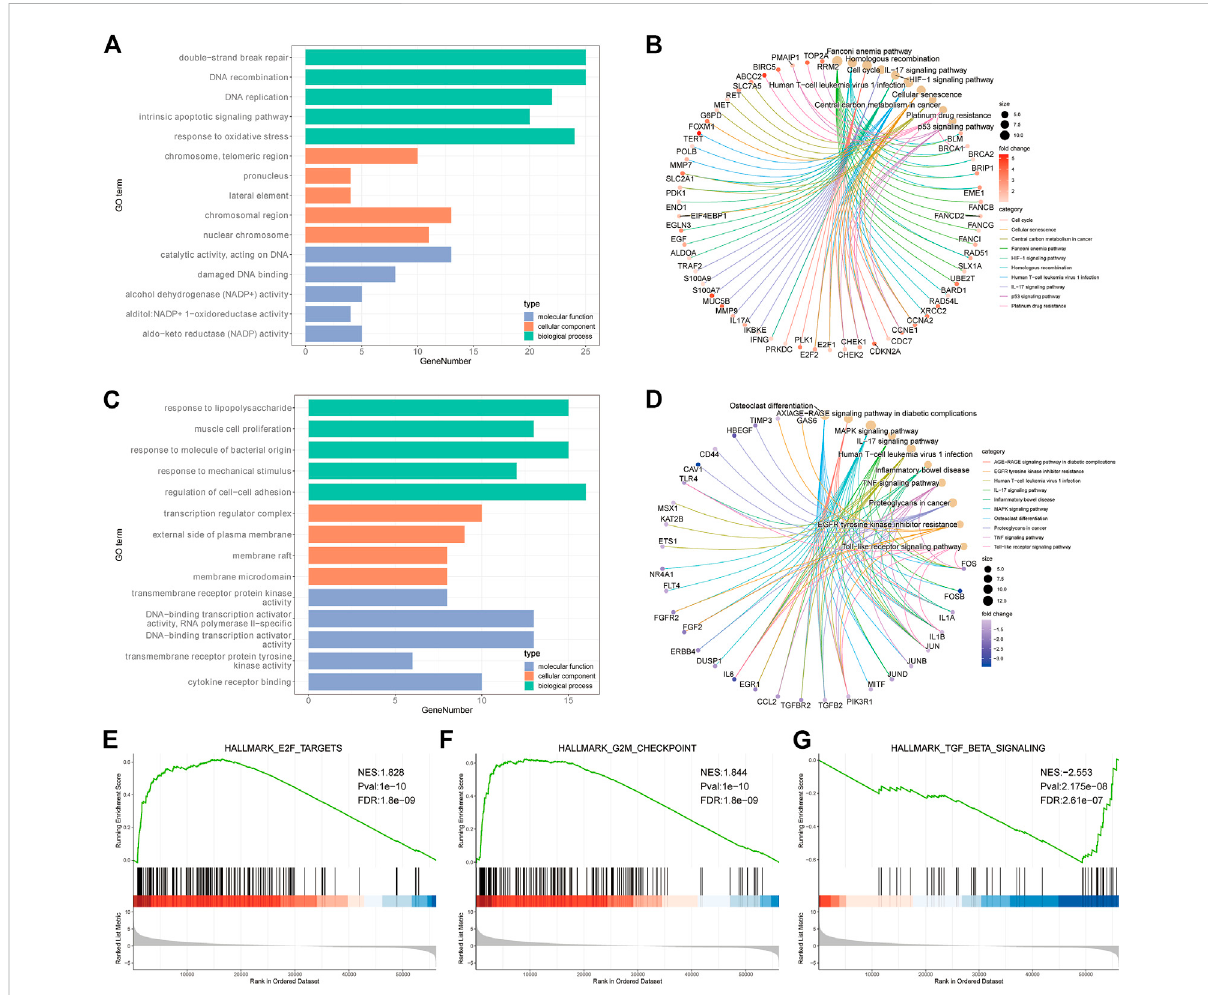
FIGURE 3 Enrichment results of GO, KEGG and GSEA. (A) GO enrichment analysis bar chart of up-regulated genes (TOP5 of BP, CC, and MF). (B) up- regulatingtheenrichmentresult ofgene KEGG. (C) GO enrichmentanalysisbar chart ofdown-regulated genes (TOP5 ofBP,CC andMF). (D) down- regulating the enrichment result of gene KEGG. (E – G) : GSEA analysis of TOP3